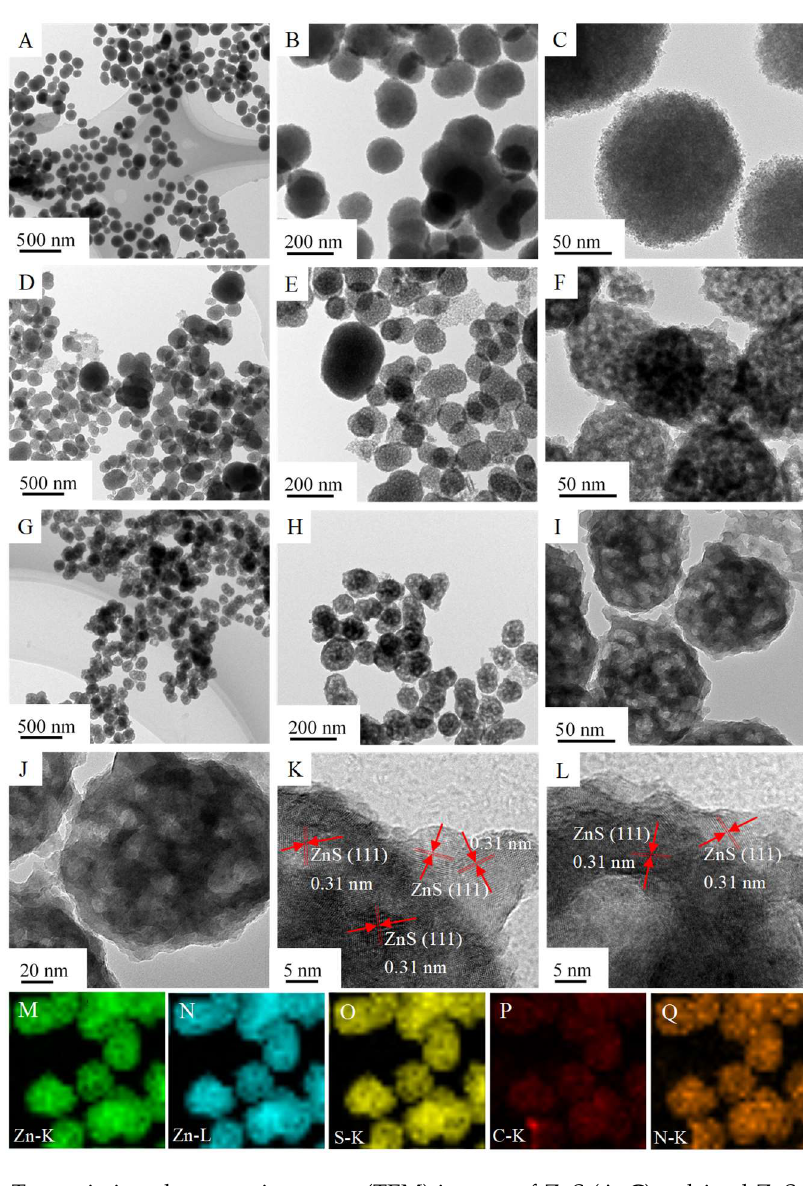
Figure 3. Transmission electron microscopy (TEM) images of ZnS ( A – C ), calcined ZnS ( D – F ) and